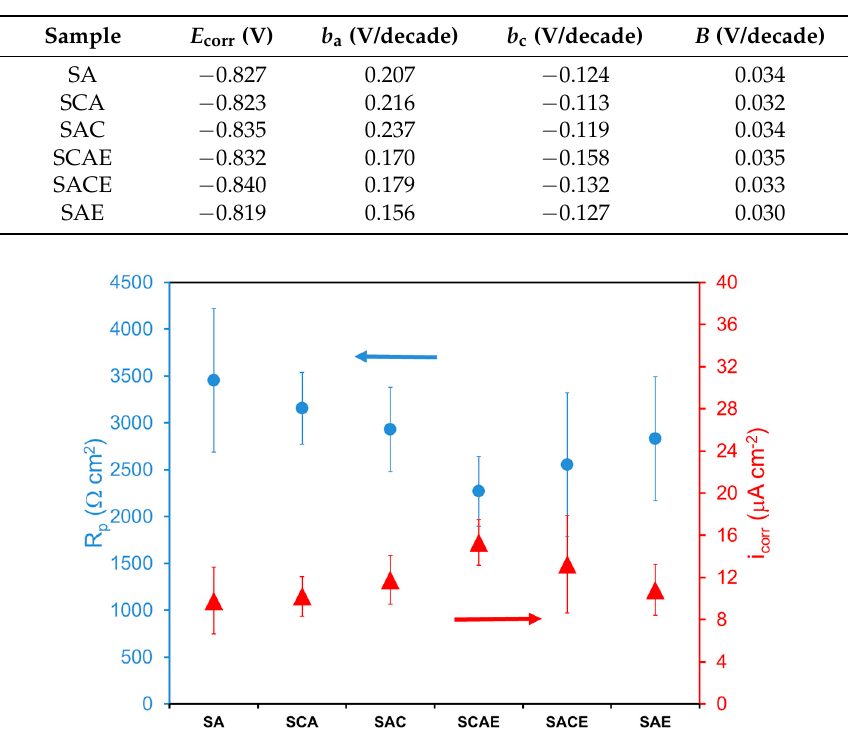
Figure 2. Polarization resistance ( R p ) and corrosion current density ( i corr ) of different AA6012 samples in deaerated solution.